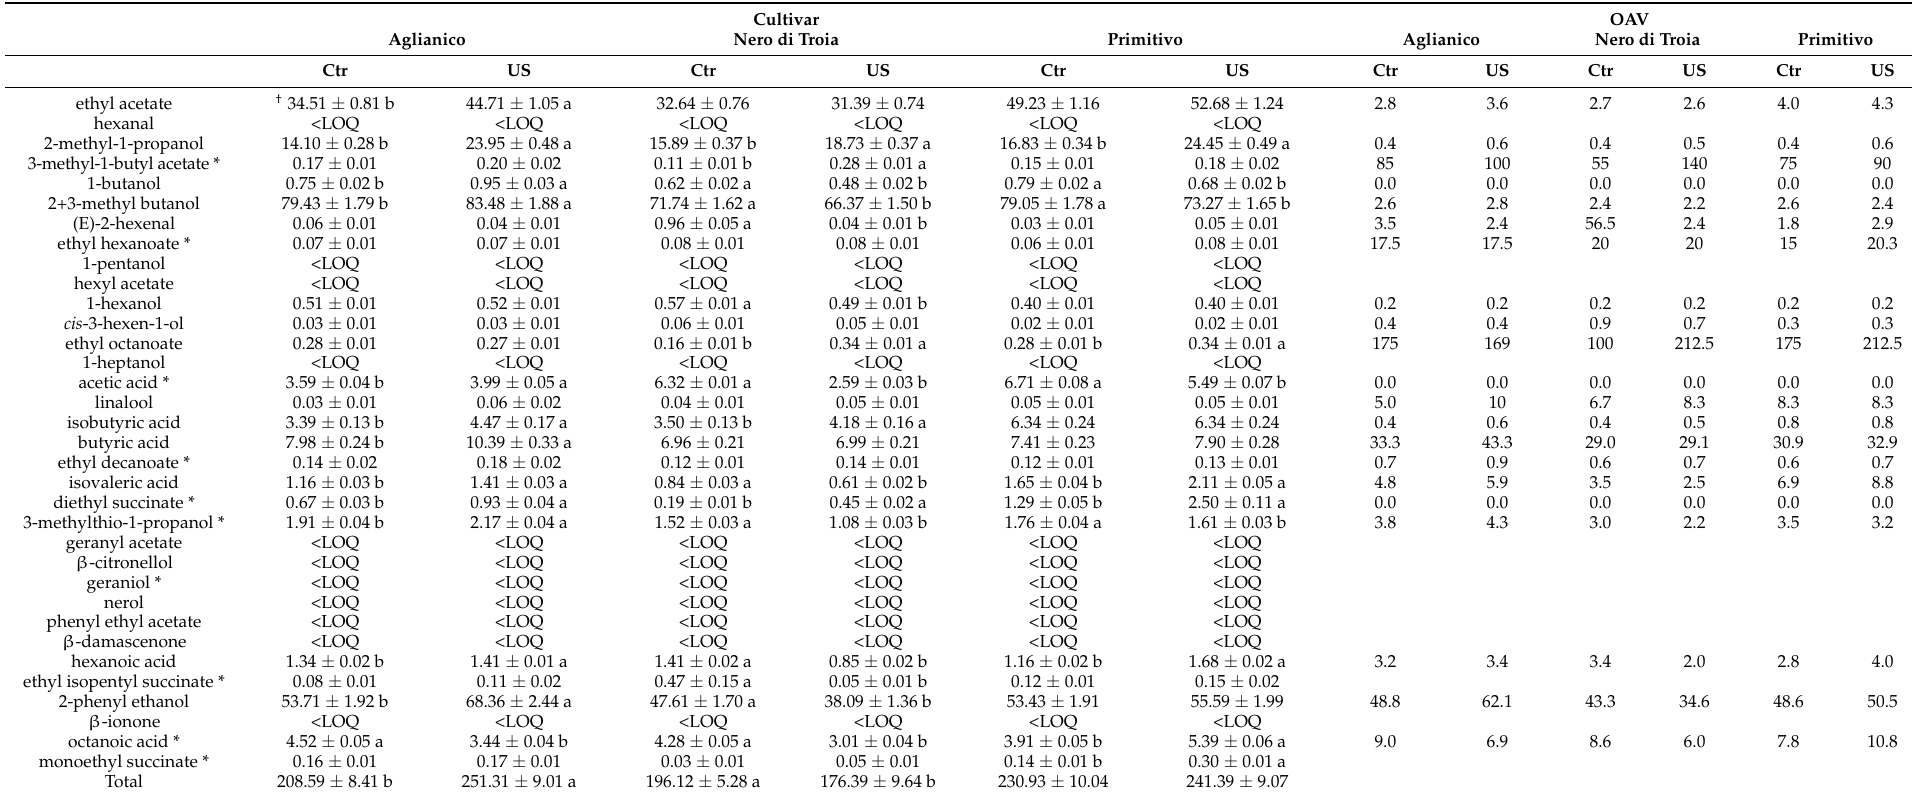
Table 2. Single volatile compound identified and quantified in control and ultrasound-treated wine samples after 7 months of aging (mg L − 1